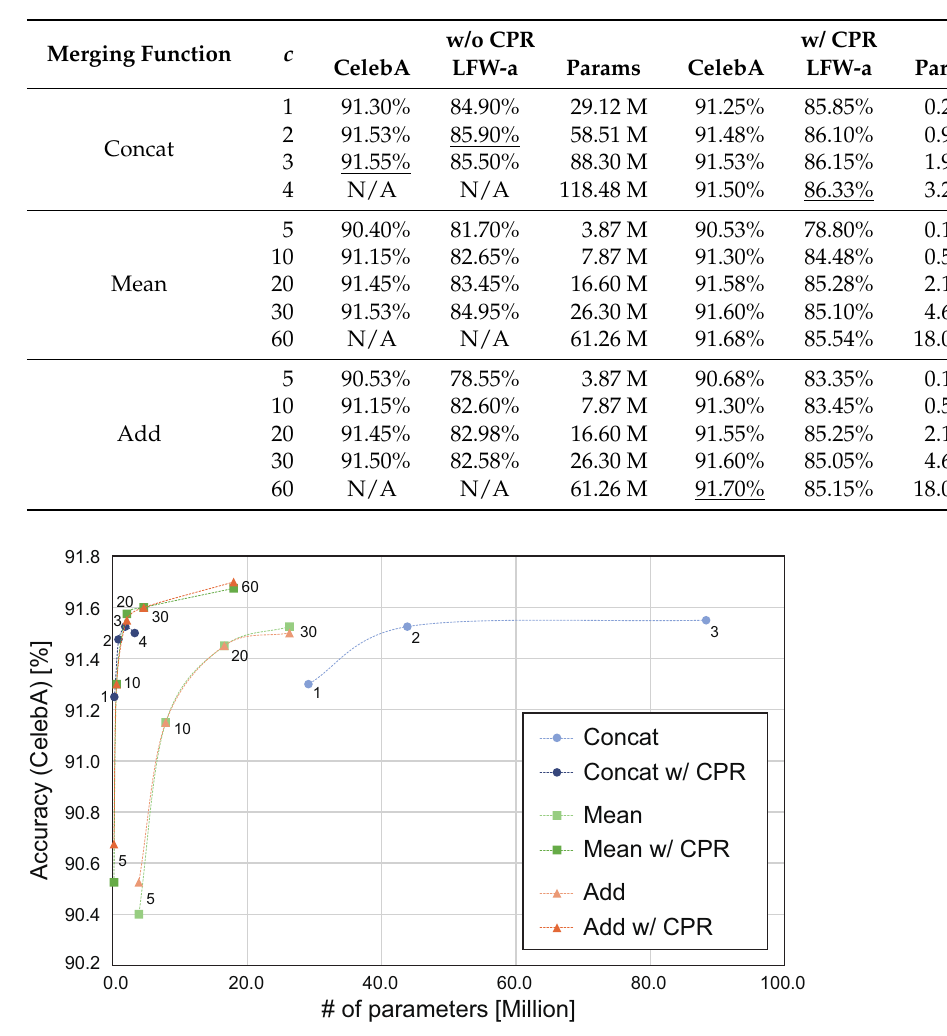
Table 5. Accuracy of face attribute estimation and the number of parameters on both datasets when changing the merging functions, c , and CPR of MM-CNN, where “N/A” means that attribute estimation cannot be done due to exceeding the maximum memory size of GPU. Best accuracy is shown with underline.